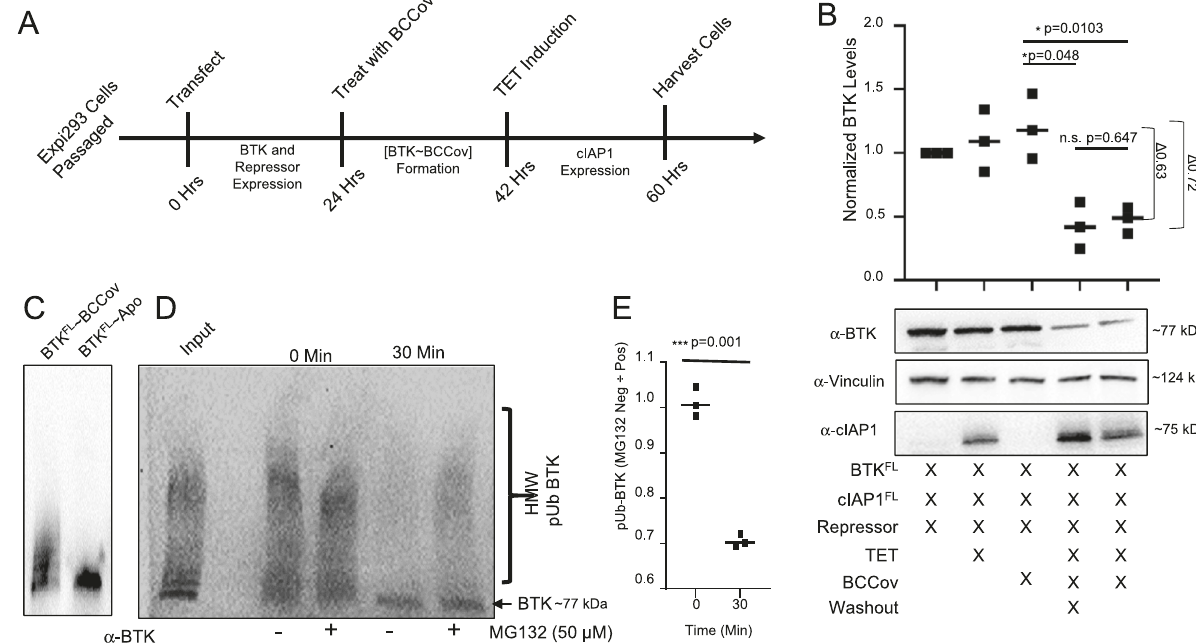
Fig.3|Covalentlymodi fi edBTKisdegraded.A Summaryofstepwiseprotocolto pre-form a binary BTK FL ~BCCov complex and induce cIAP1 FL using tetracycline. B Western blot analysis of BTK FL , vinculin, and cIAP1 FL with or without BCCov treatment, tetracycline induction, and compound washout. Mean values from 3 individual experiments were normalized to lane 1 and plotted as a scatter plot around the median. C Western blotofBCCov-dependent in vitroubiquitination of BTK FL . The western is a representative blot from 3 independent experiments. D Western blot depicting in vitro (lysate) proteasomal degradation of